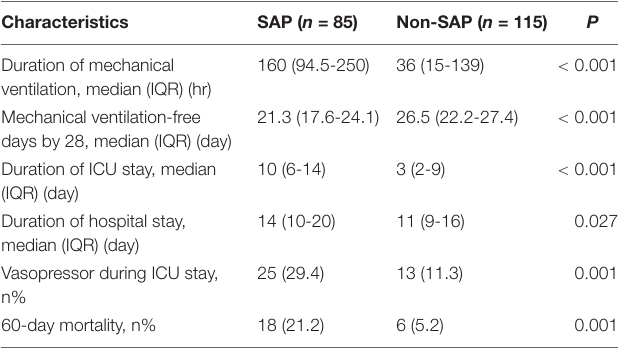
TABLE 4 | Outcomes of the patients with microbiologically confirmed SAP compared with matched control.